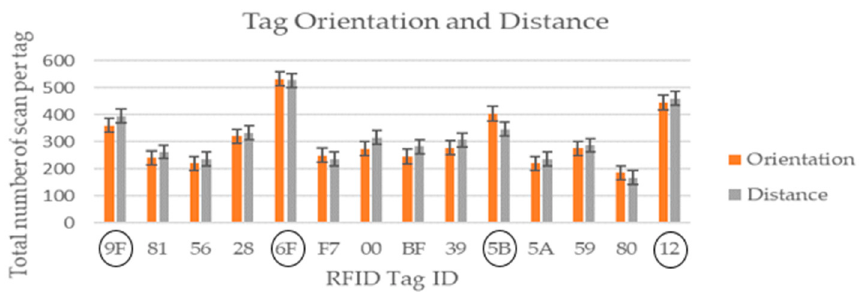
Figure 10. Results for the total number of scans per tag over 6.5 minutes.